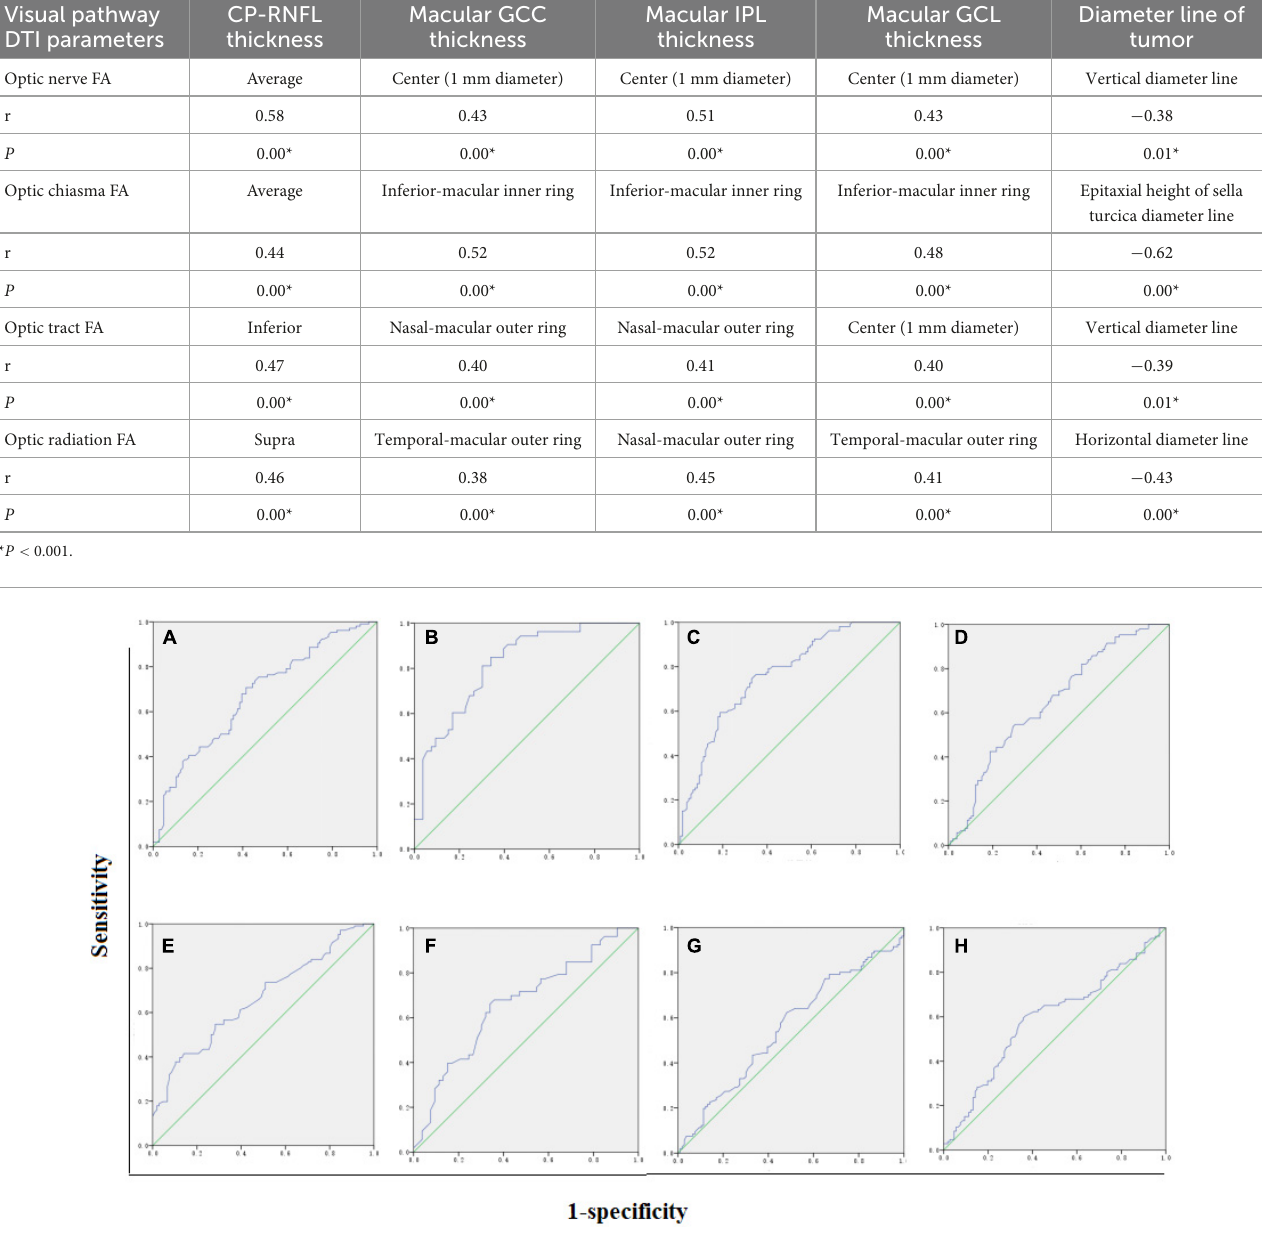
FIGURE3 AUC of FA and ADC values. (A) Optic nerve FA = 0.68. (B) Optic chiasma FA = 0.82. (C) Optic tract FA = 0.76. (D) Optic radiation ADC = 0.65. (E) Optic nerve ADC = 0.66. (F) Optic chiasma ADC = 0.66. (G) Optic tract ADC = 0.55. (H) Optic radiation ADC =